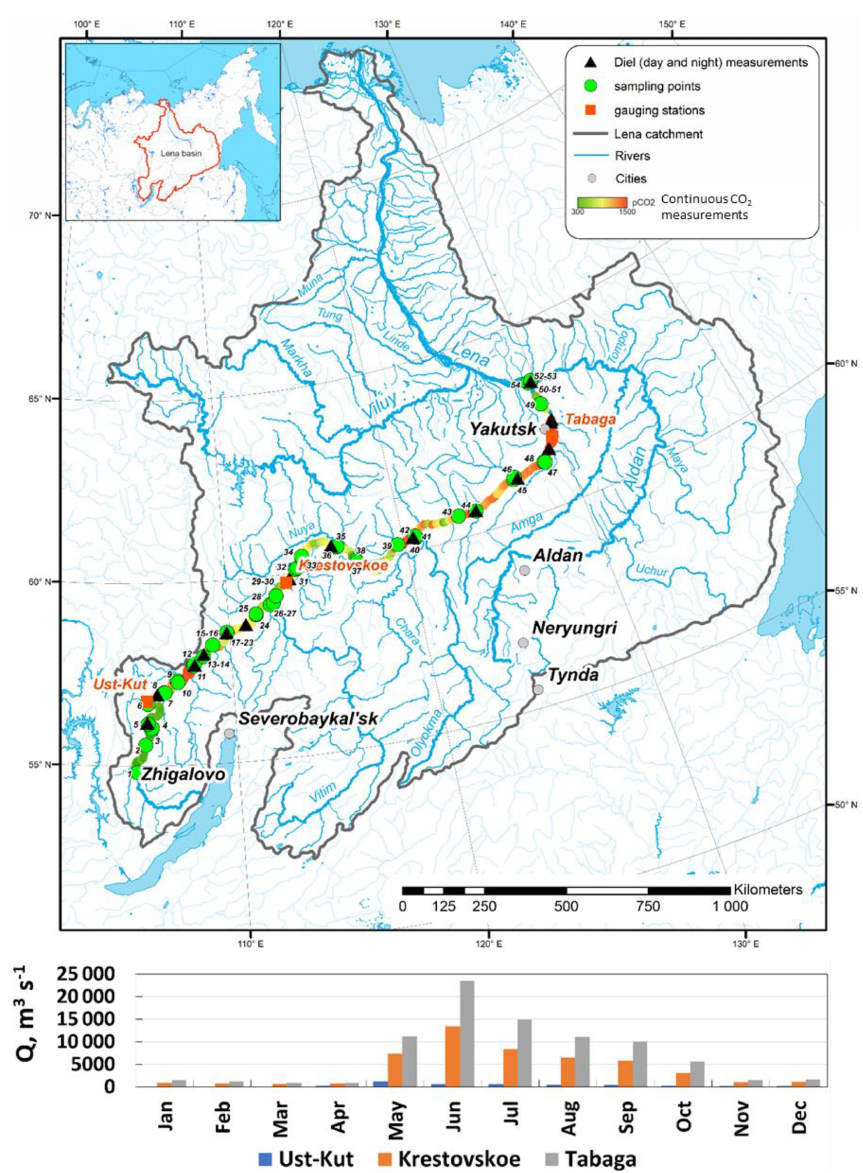
Figure 1. Map of the studied Lena River watershed with continuous p CO 2 measurements in the main stem. Bottom: mean multi-annual monthly discharge ( Q ) at Ust-Kut, Krestovskoe, and Tabaga stations (labeled in red on the